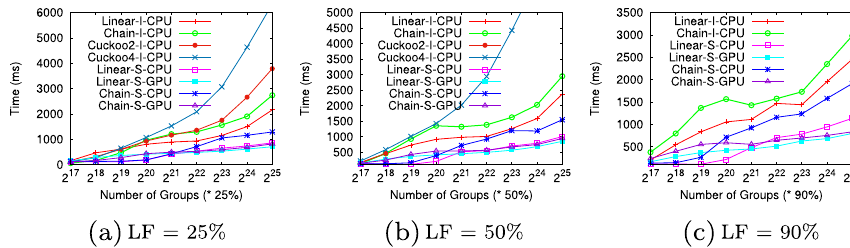
Fig. 6 Performance as the number of groups changes with different load factors when the data has 2 25 (32M)